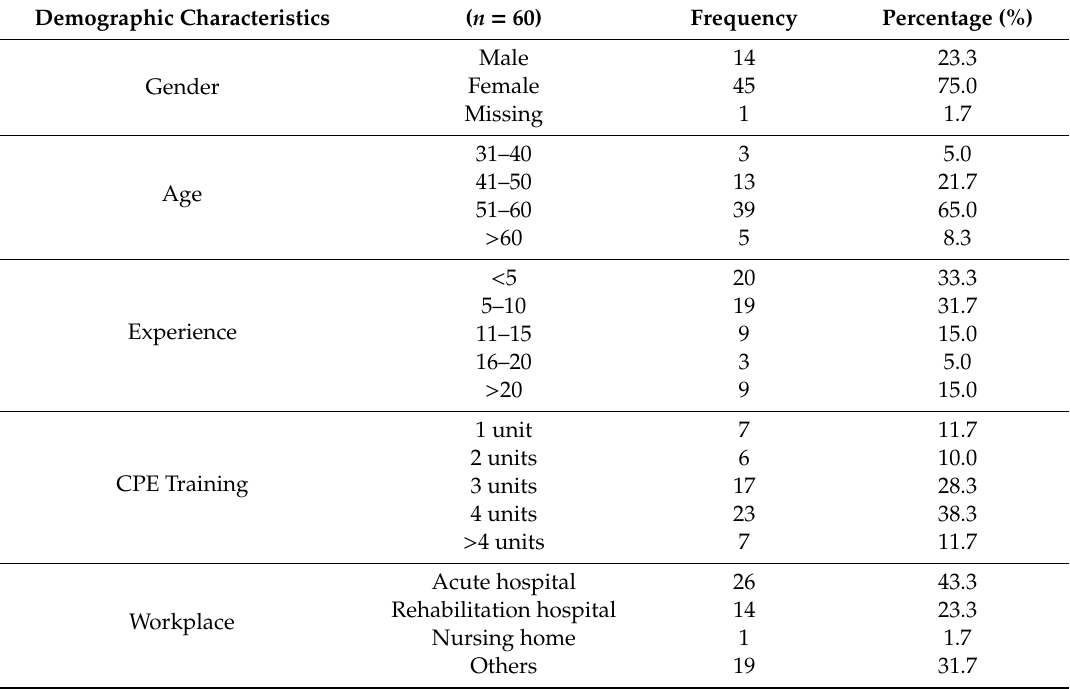
Table 1. Background